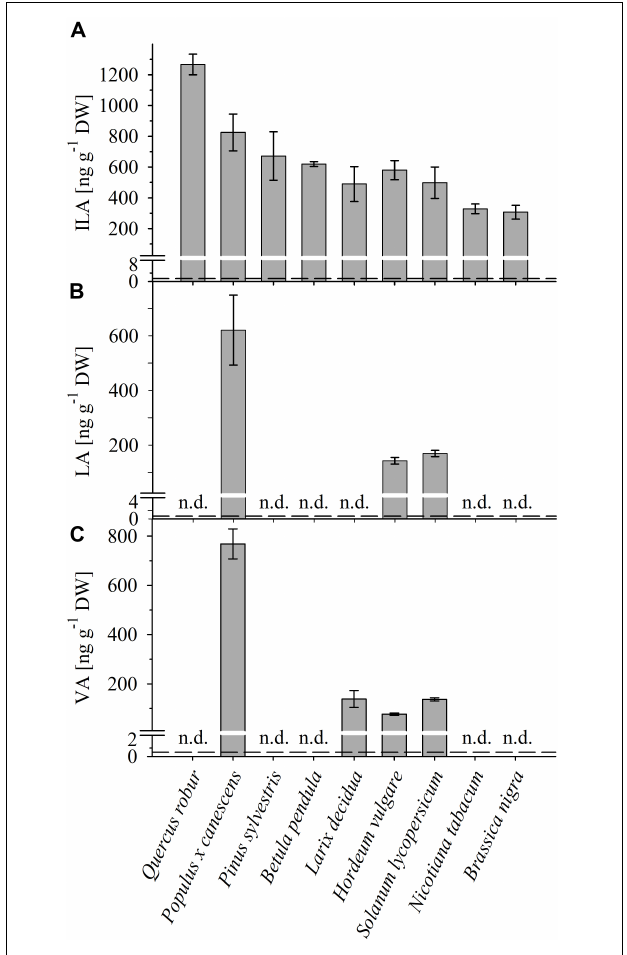
FIGURE 2 | Detection of ILA, LA, VA in different plant species. Abundance of (A) ILA, (B) LA, and (C) VA in leaf extracts of monocot ( Hordeum vulgare ) and dicot crops ( Solanum lycopersicum, Nicotiana tabacum, Brassica nigra ), as well as of broadleaf ( Quercus robur , Populus x canescens, Betula pendula ) and coniferous ( Pinus sylvestris , Larix decidua ) trees. Means ± SE ( n = 3–4) are plotted; n.d., not detected. Dashed lines indicate the limit of detection (see section “Materials and